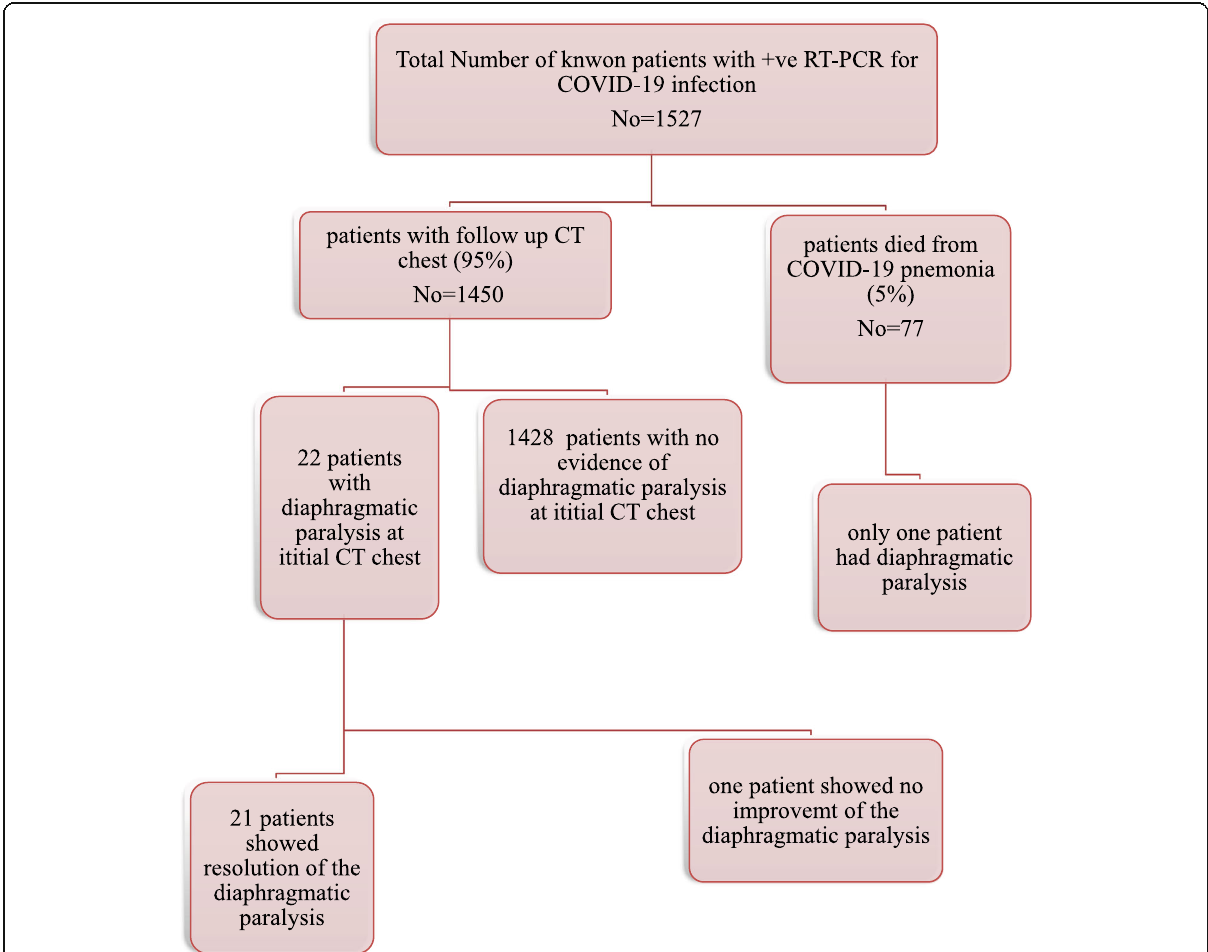
Fig. 1 Algorithm representing the demographic data and study